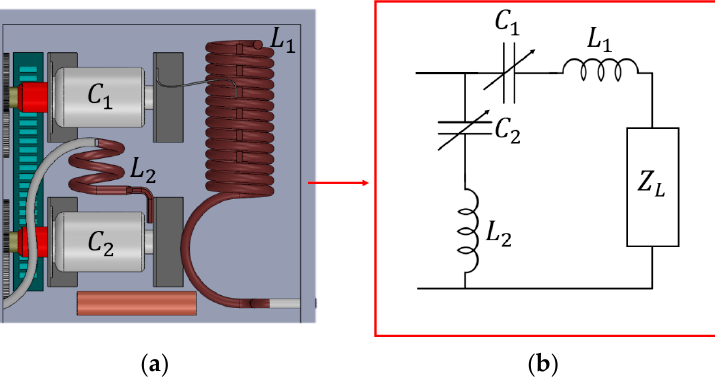
Figure 6. ( a ) The matching box for the measured RF-driven PECVD power source; ( b ) The schematic equivalent circuit model of RF power transmission.